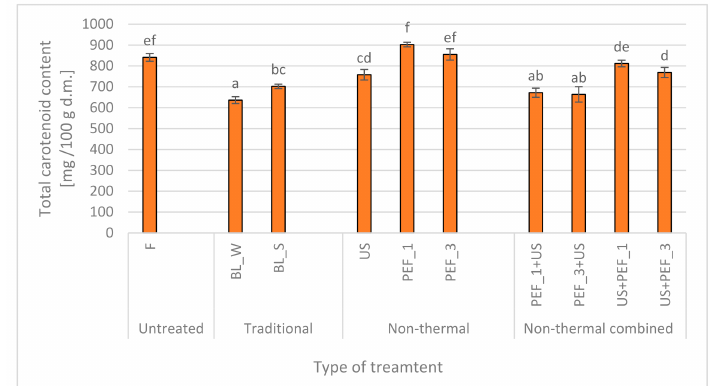
Figure 1. Total carotenoid content in fresh (F) red bell peppers and subjected to traditional (blanching in water, BL_W, and blanching in steam, BL_S) and non-thermal separate (US—ultrasound, PEF_1 and PEF_3—pulsed electric field with energy input 1 and 3 kJ / kg, respectively) and combined treatment (PEF + US and US + PEF), the same letters indicate homogeneous groups (Tukey’s HSD, p < 0.05), the error bars represent the standard deviation calculated from 3